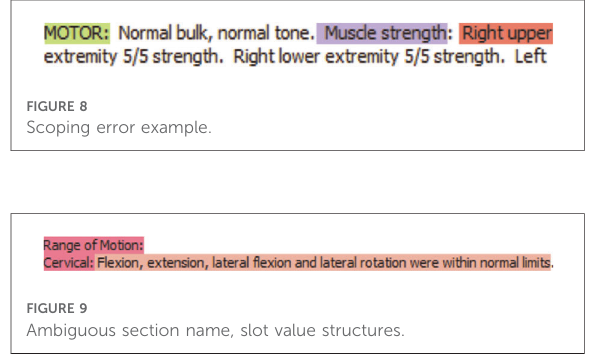
FIGURE 9 Ambiguous section name, slot value structures.